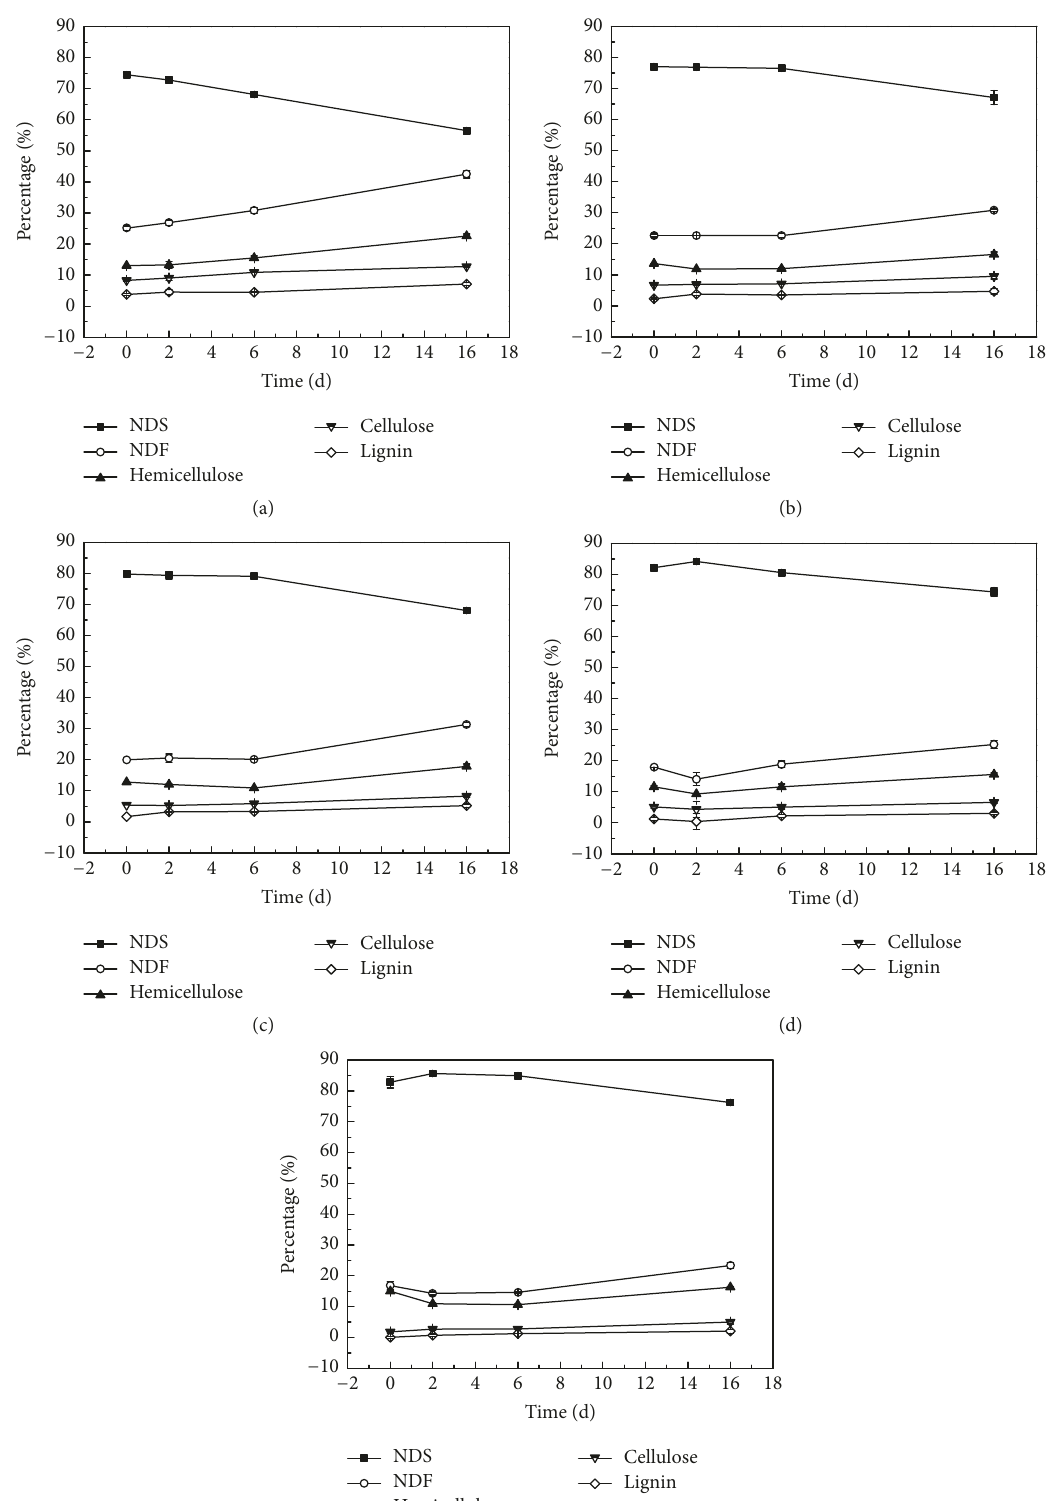
Figure 7: Evolution of the proportions of biochemical fractions (NDS, NDF, hemicellulose, cellulose, and lignin) in the composting of KW. (a), (b), (c), (d), and (e) represent R1, R2, R3, R4, and R5,